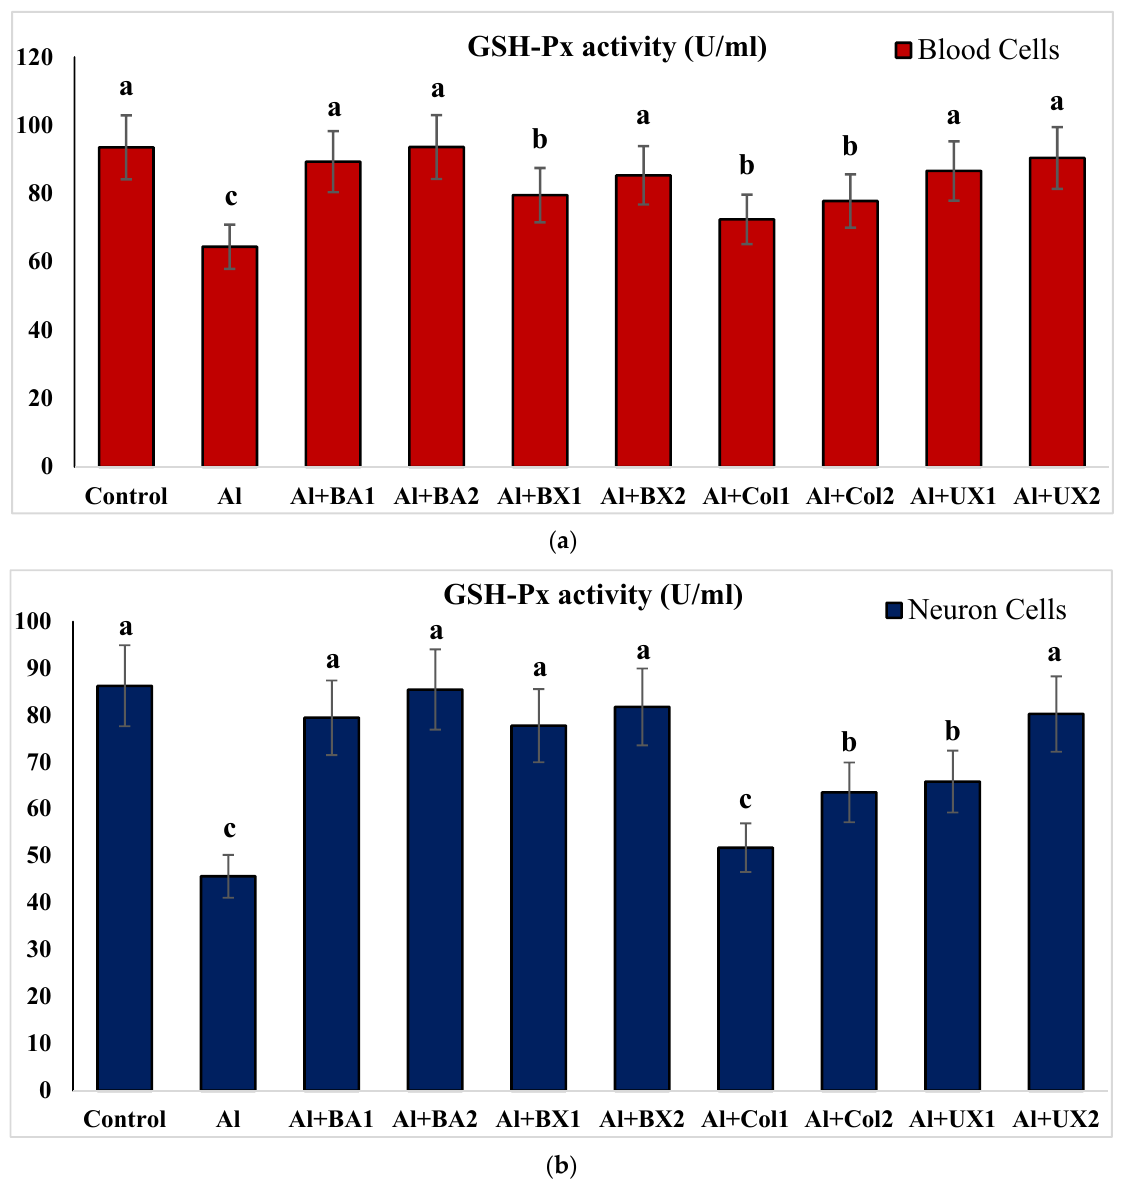
Figure 4. The effect of Al and boron treatments in ( a ) human blood and ( b ) PRCNs on GSH-Px activity. Abbreviations are as in Figure 2. (Each superscript letter (a, b, c) represents statistically similar groups).